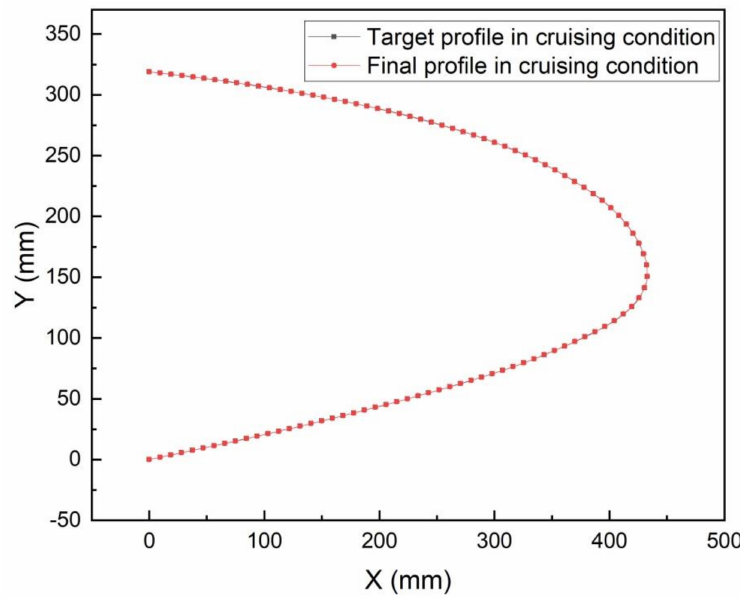
Figure 20. Comparison of the profiles in the target case and the final case.